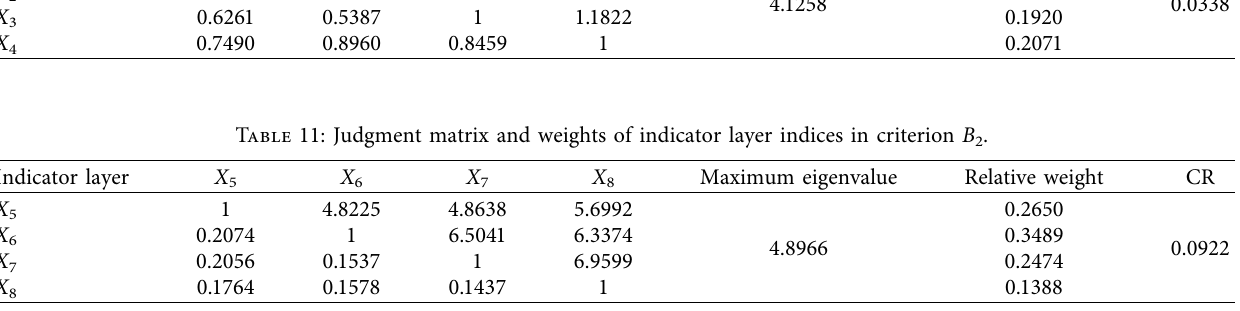
Table 12: Judgment matrix and weights of indicator layer indices in criterion B